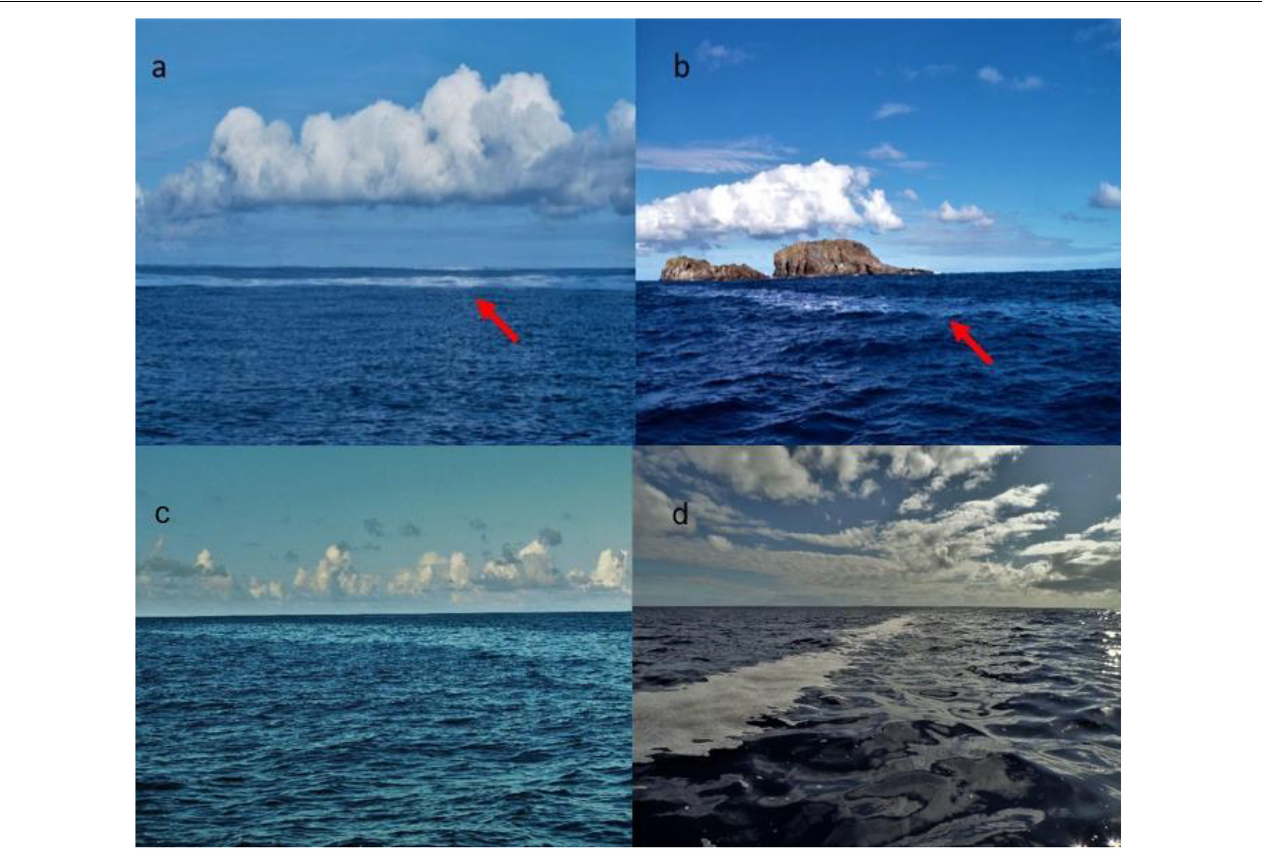
FIGURE 2 | Examples of sea slicks (red arrows) visible at the sea surface along the coast of Rapa Nui. Sea slicks are characterized by (a,b) a smoother sea surface than the surrounding water, (c) changes in water color, and (d) the presence of foam, bubbles and/or floating debris. Sampling dates: (a) 12 January 2018; (b–d) 5 May